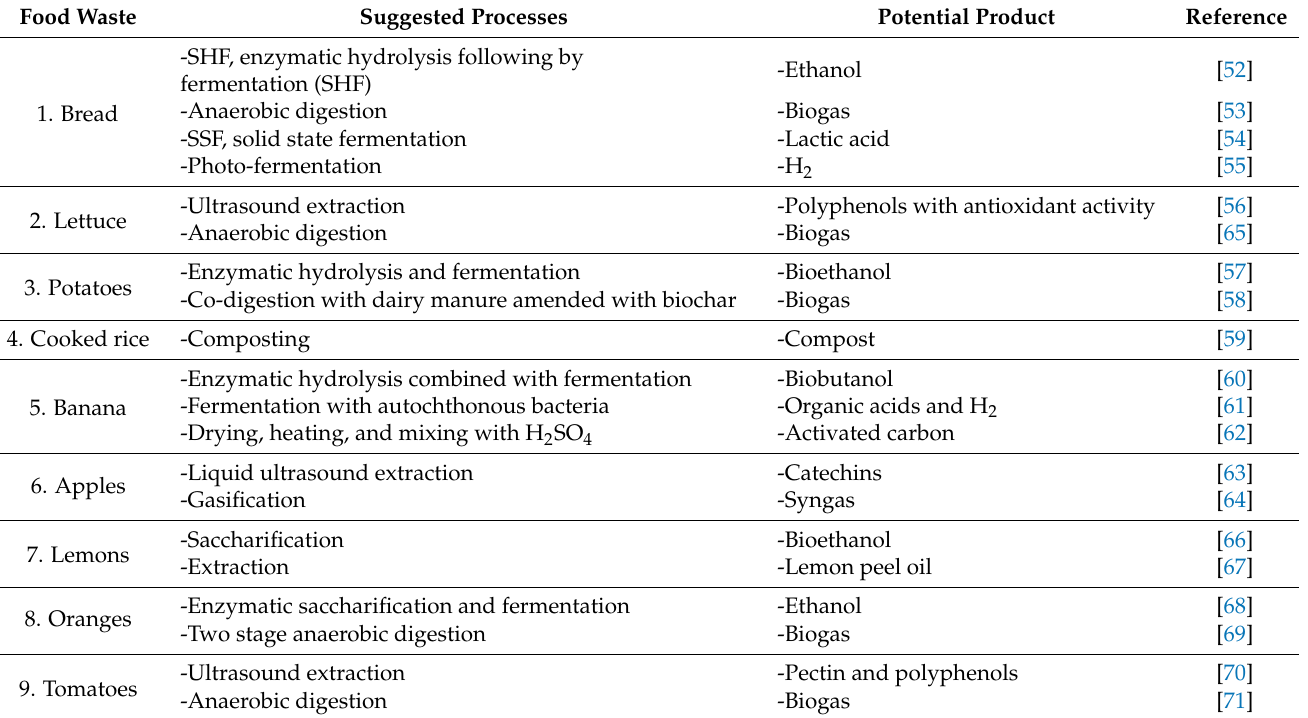
Table 4. Recommendations for household food waste